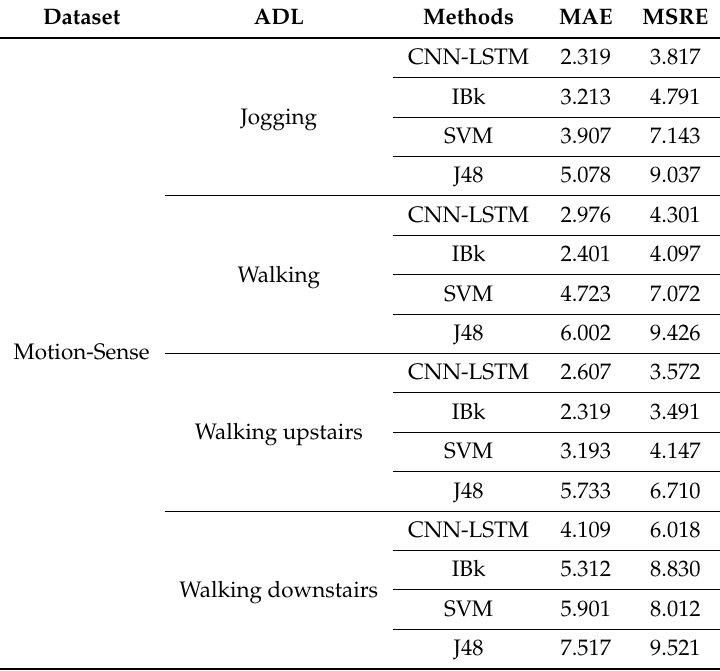
Table 4. The experimental results on Motion-Sense without data